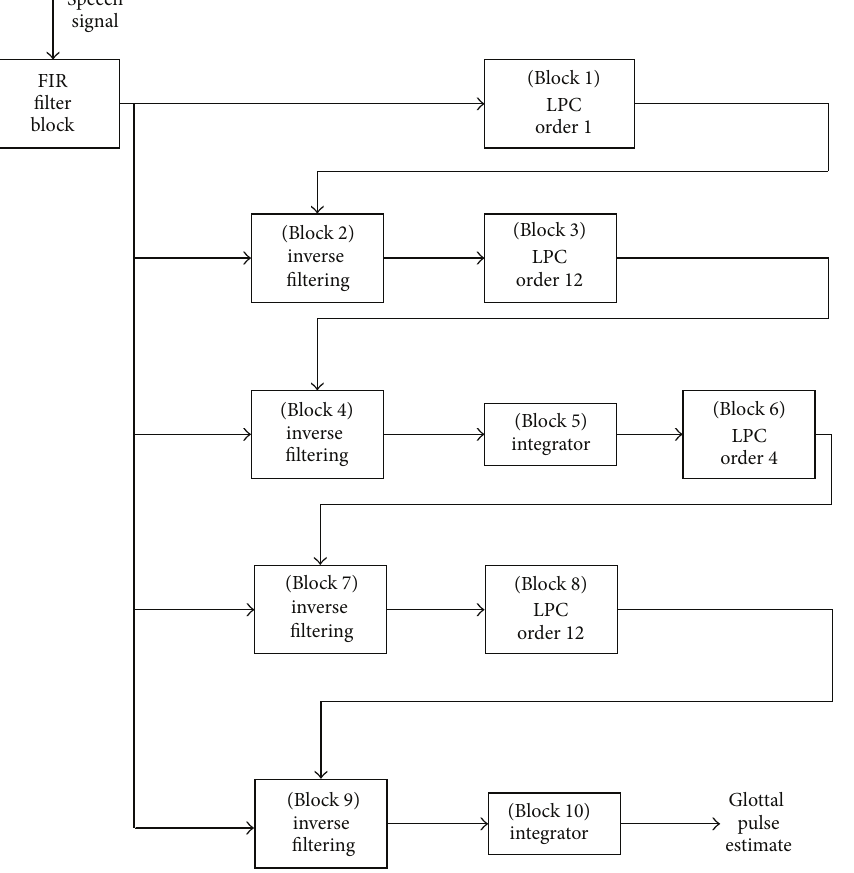
Figure 3: Block diagram of